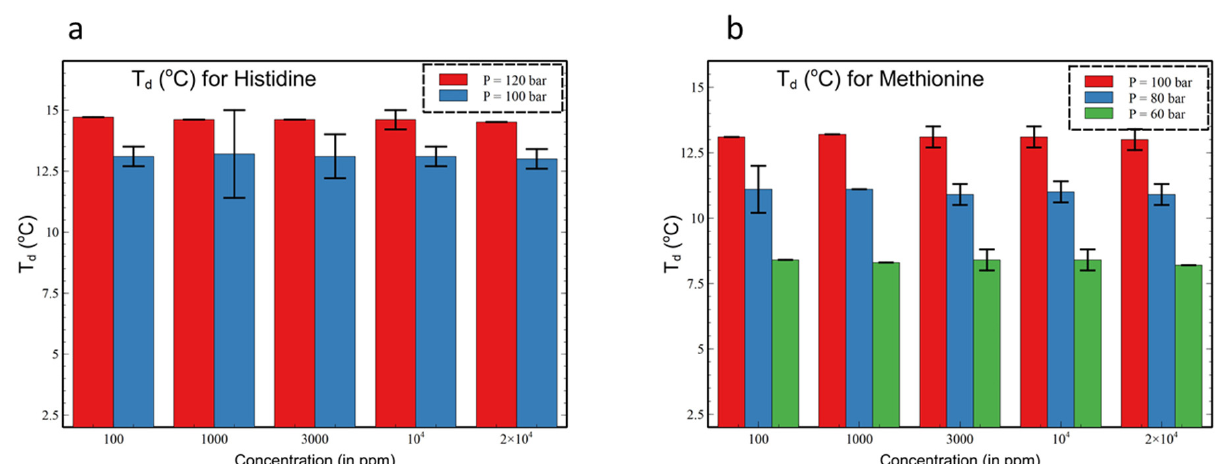
Figure 6. Dissociation temperature (T d ) during an isothermal experiment at 1 °C (for histidine and methionine) at five different concentrations (100 ppm to 20,000 ppm). ( a ) Dissociation temperature T d for histidine under two different starting pressures (100 and 120 bar.) ( b ) Dissociation temperature T d for methionine under three different starting pressures (60 bar, 80 bar and 100 bar).